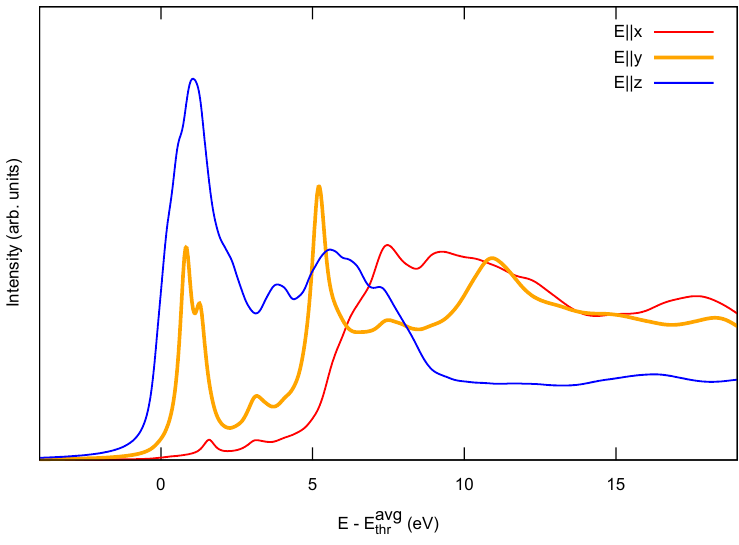
Figure 5. Simulated NEXAFS spectrum of bBEBP/Au(111). See Figure 3a for the definition of the x , y , z polarization